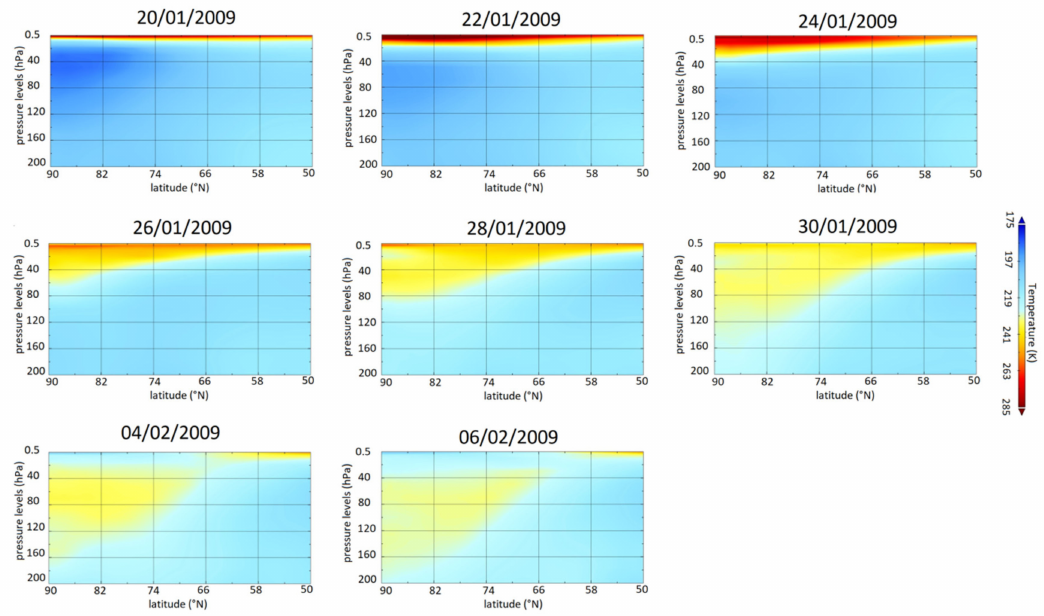
Figure 7. Vertical profile of polar temperature during sudden stratospheric warming (SSW) in 2009 in the Northern Hemisphere (NH).